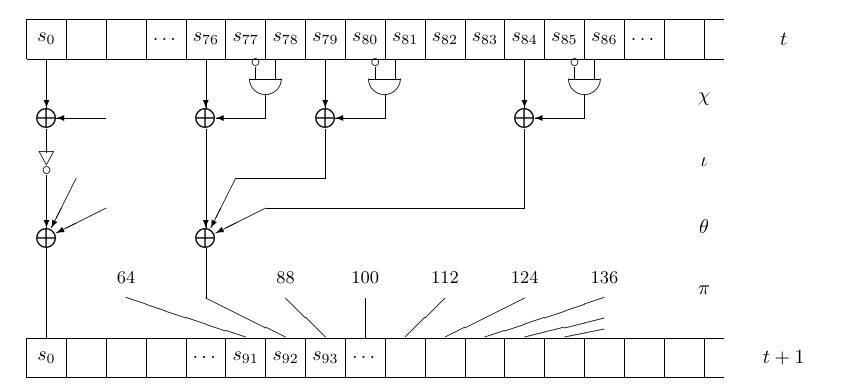
Figure 1: Subterranean round function, illustrated for bit s